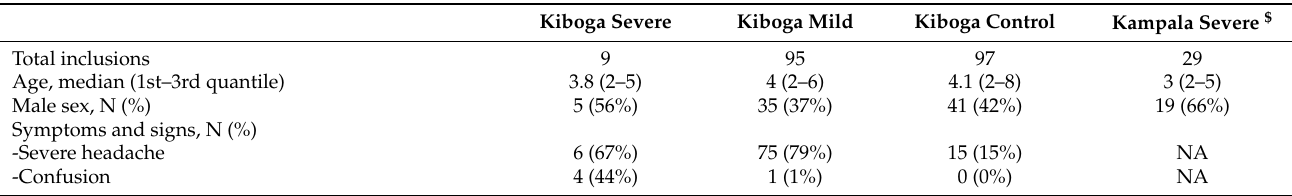
Table 2. Patient